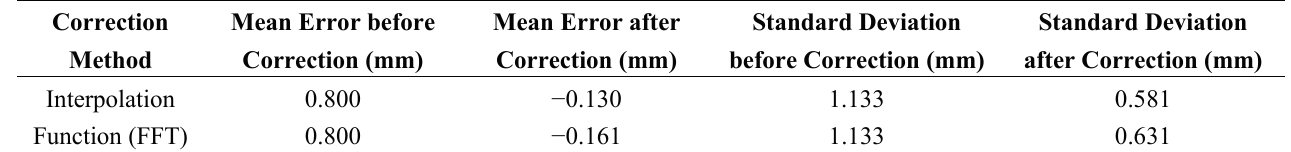
Table 15. Effectiveness of the corrections application–Trimble M3, 47 distances.